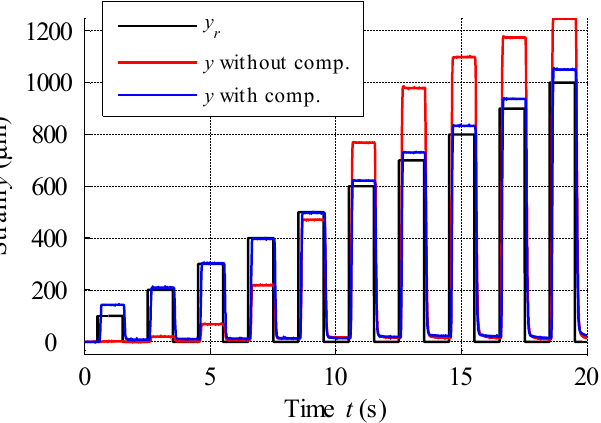
Figure 21. Open-loop control for a series of rectangular position references with increasing amplitude.